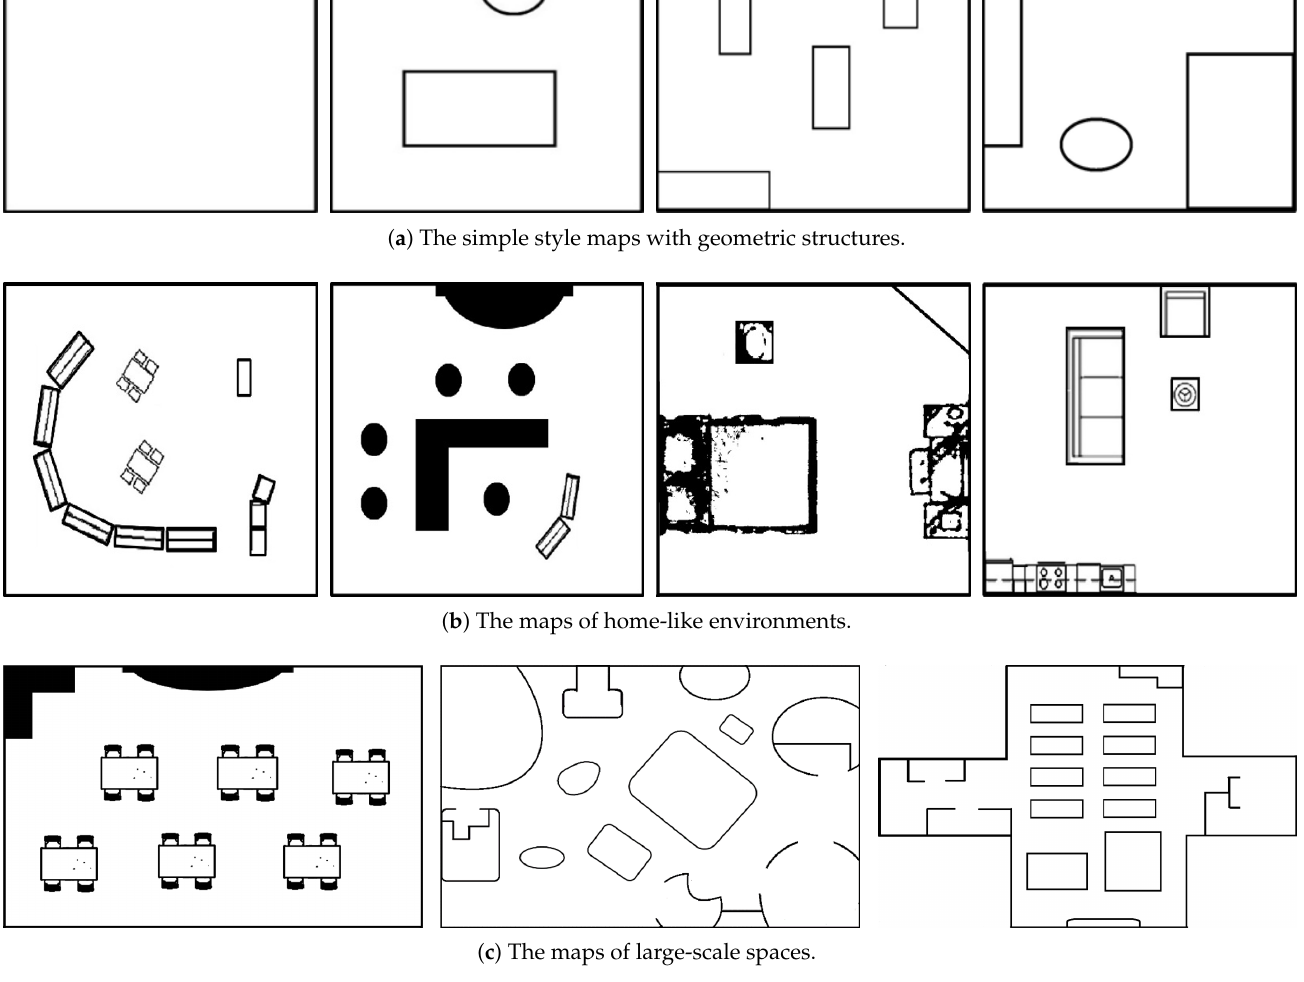
Figure 1. Several typical maps of interest used to evaluate the proposed CCPP algorithms. There are simple style maps with geometric structures, home-like environments, and large-scale